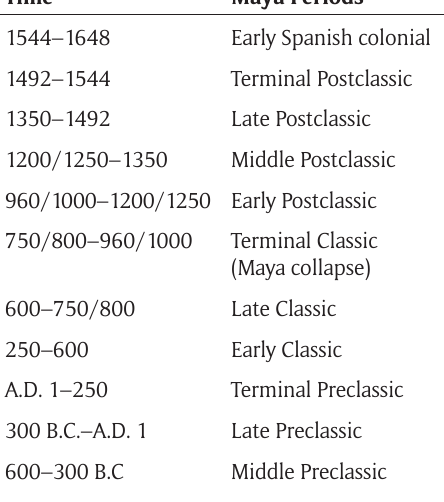
Table 1: Marco Gonzalez